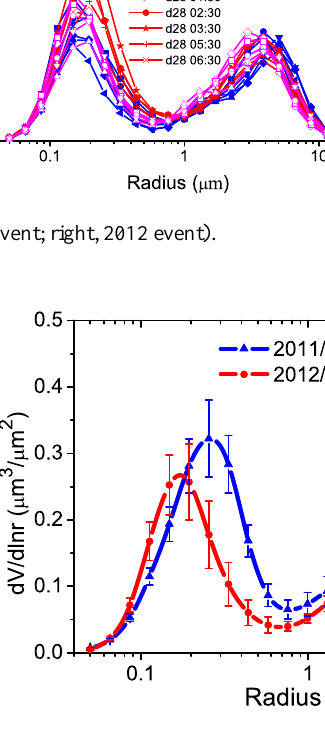
Fig. 7. Comparison of the average size distribution of the two haze events in February 2011 and